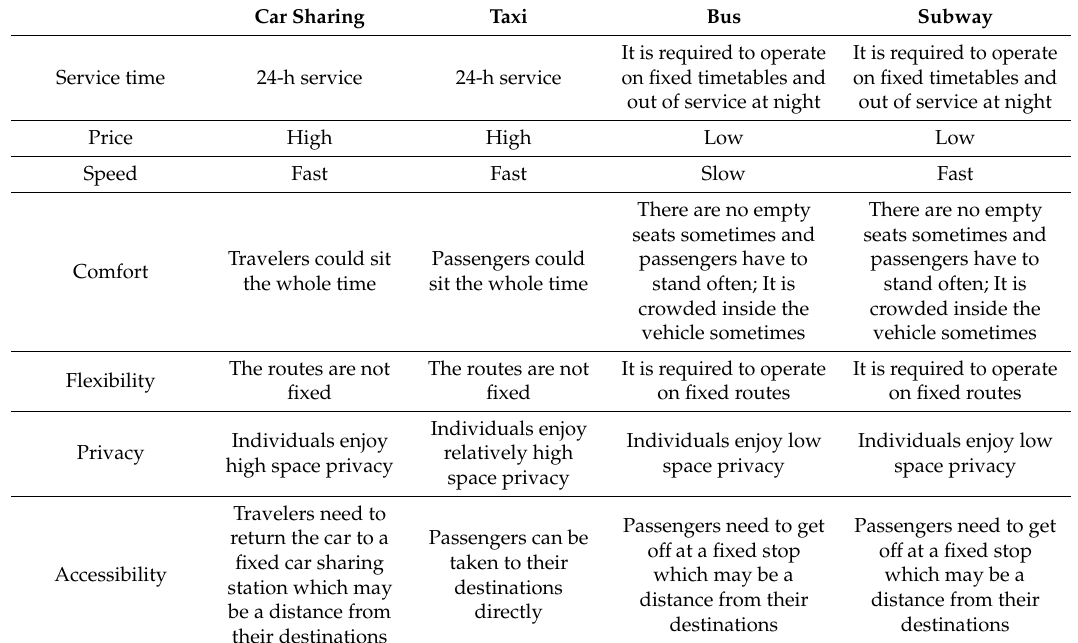
Table 1. The comparison between car sharing, taxi, bus and